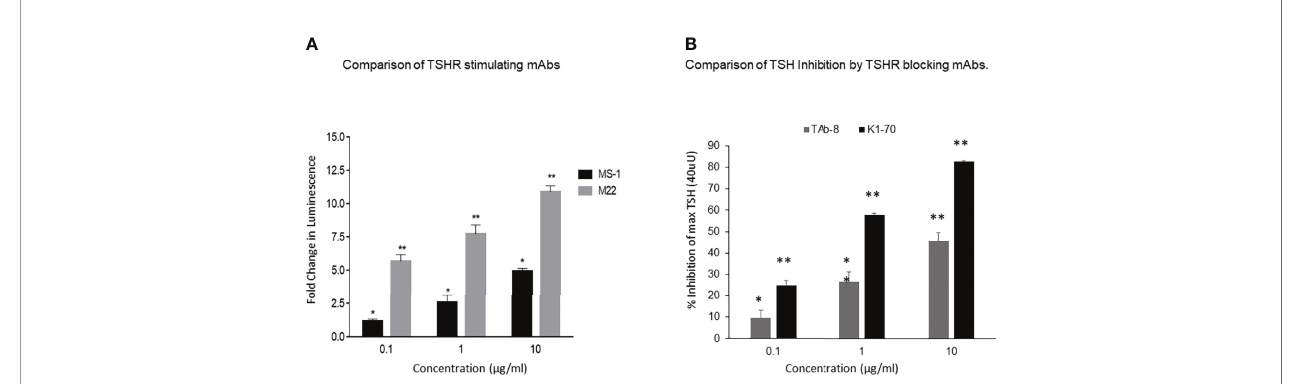
FIGURE 1 | Activation of receptor by stimulating TSHR mAbs with variable potency and inhibition of TSH by strong and weak TSHR blocking mAbs.These and subsequent data was obtained using Chinese Hamster Ovary (CHO) cells transfected with the human TSHR (7). (A) Here we show the TSHR stimulating activity of a highly potent (M22) (grey bars) versus a weaker (MS-1) stimulating TSHR mAb (black bars), as measured by deduced cAMP generation in the bioassay. The fold changes of the responses indicated in the y-axis are based on luminescence (luciferase units). These data show the difference in the potency of these two antibodies in stimulating the TSHR and illustrate that in patients with Graves ’ disease there is likely to be much variability in the biological activity of the stimulating antibodies even without the possible presence of blocking antibodies. By de fi nition, TSH signaling is inhibited by both highly potent and weaker blocking TSHR antibodies when measured using a TSH bioassay. * = p<0.05, ** = p<0.01 (B) A weaker blocking antibody, shown here, was a hamster mAb (TAb-8) which gave ~45% maximum inhibition of TSH stimulation (dark gray bars) at the highest dose tested in the CHO-TSHR cells. In contrast, a stronger human blocking mAb (K1-70) was able to